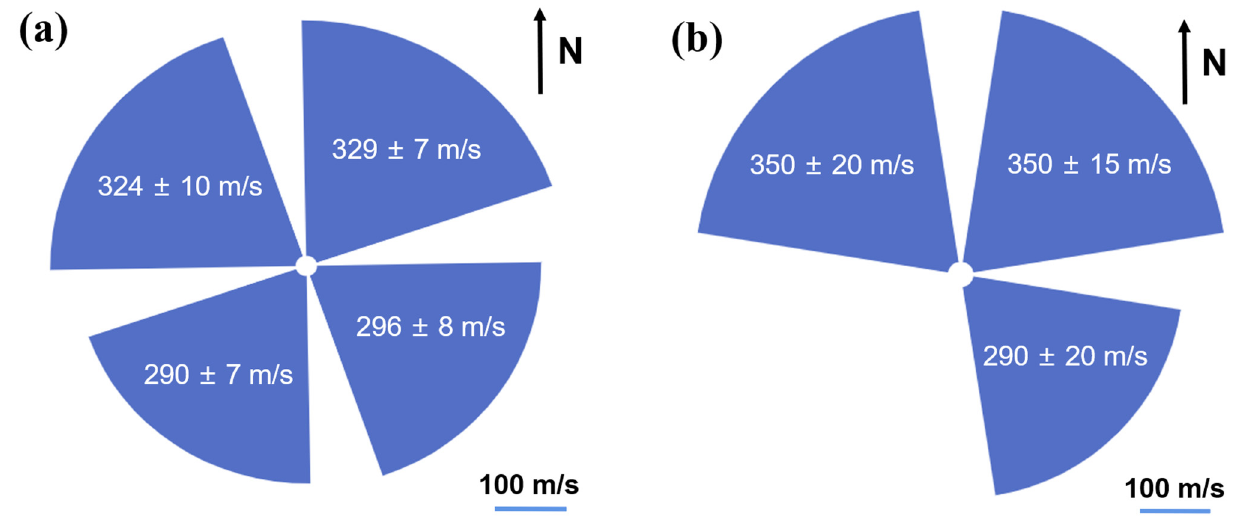
Figure 10. Propagation velocity of Lamb waves in all directions caused by the eruption of Tonga volcano. ( a ) in the far-field. ( b ) in the near-field.